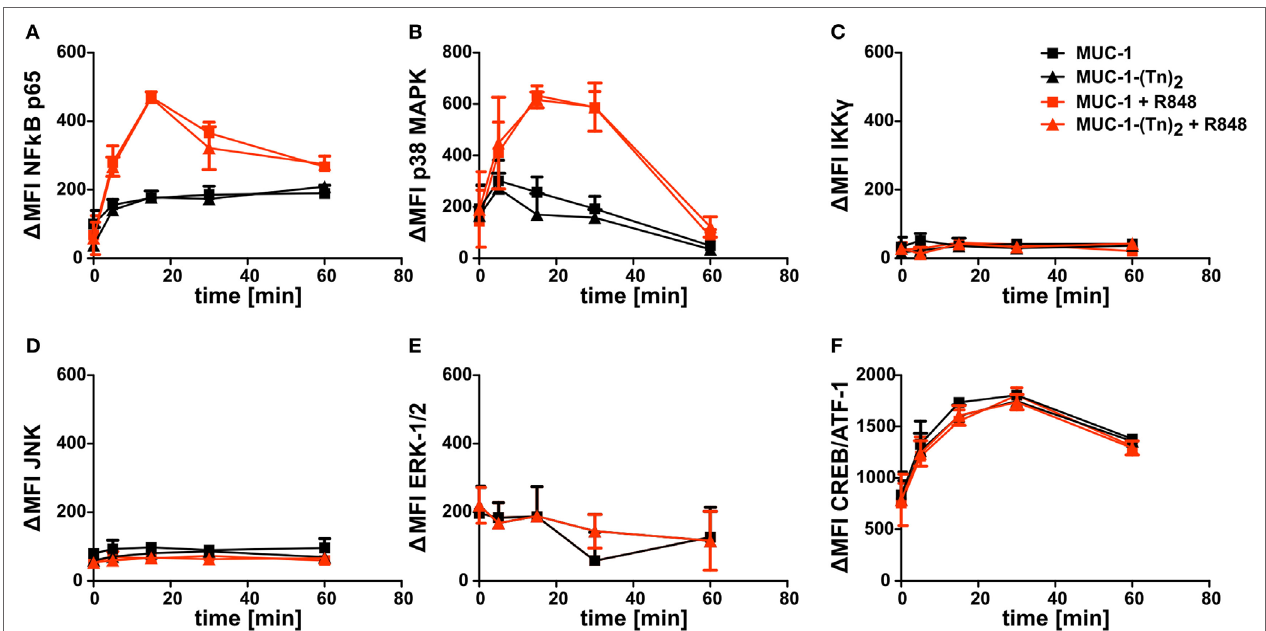
FigUre 7 | Intracellular signaling in CD1c + dendritic cells (DCs) induced after stimulation with a ligand for CLEC10A. CD1c + DCs were sorted from PBMCs of healthy donors. Subsequently, cells were stimulated with MUC-1-(Tn) 2 (triangles) or non-glycosylated MUC-1 (squares) as control together with (red curves) or without 5 µg/ml R848 (black curves) for different time points (0, 5, 15, 30, and 60 min) at 37°C. Afterward, the cells were fixed and permeabilized using BD Perm Buffer III and intracellularly stained for phosphorylated (a) NF κ B p65, (B) p38 MAPK, (c) IKK γ , (D) , JNK, (e) ERK-1/2, and (F) CREB/ATF-1 with BD Phosflow antibodies. Diagrams show Δ MFI ± SD for two donors. Δ MFI = MFI antibody − MFI Isotype